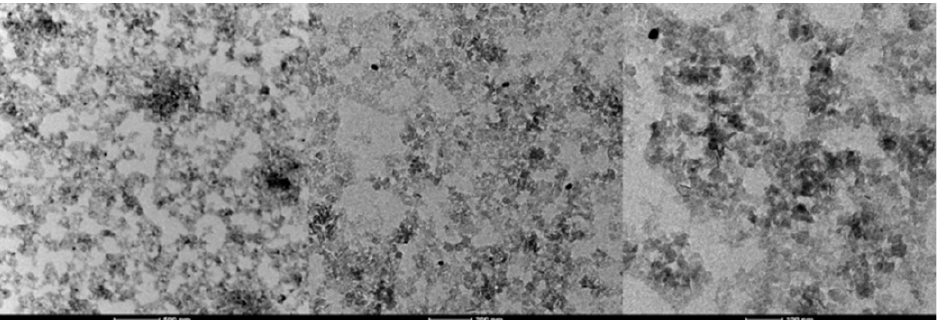
Figure 7. TEM image of Au − Al 2 O 3 hybrid nanofluid.